Question: Write a caption explaining this figure to a reader.
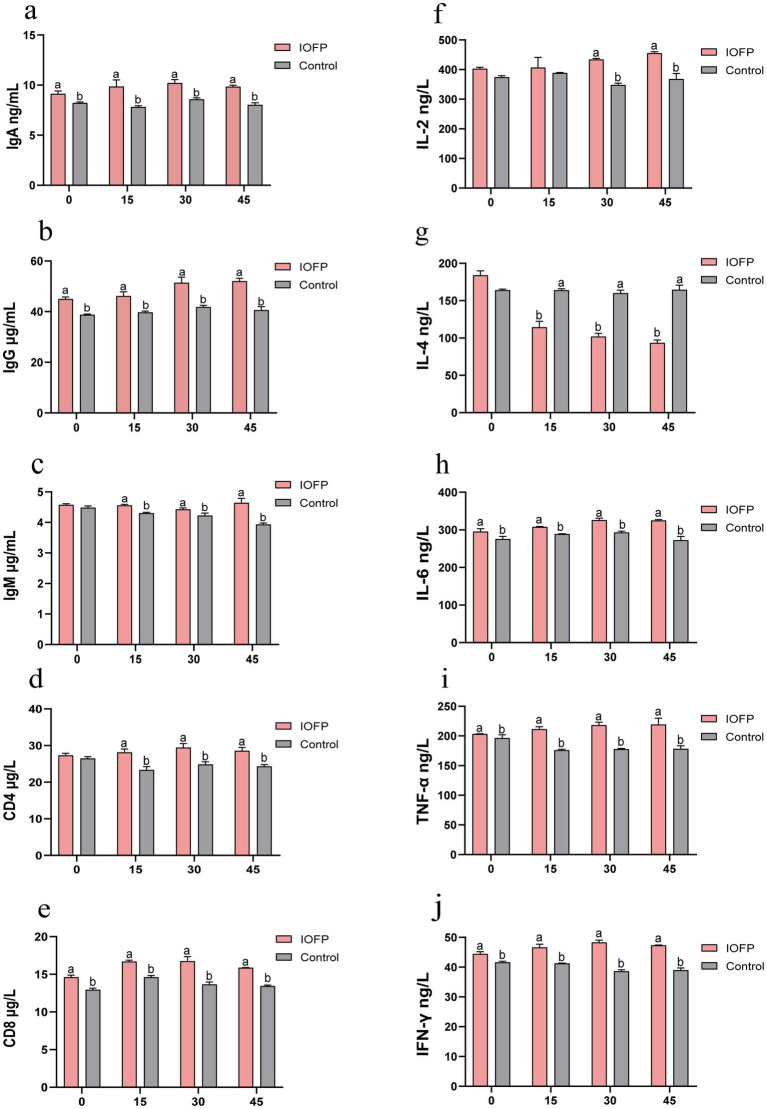
Answer: Effect of Inonotus obliquus fermentation product (IOFP) on serum biochemical indicators of cats. (a) Concentrations of IgA in the IOFP and control groups. (b) Concentrations of IgG in the IOFP and control groups. (c) Concentrations of IgM in the IOFP and control groups. (d) Concentrations of CD4 in the IOFP and control groups. (e) Concentrations of CD8 in the IOFP and control group. (f) Concentrations of IL-2 in the IOFP and control group. (g) Concentrations of IL-4 in the IOFP and control group. (h) Concentrations of IL-6 in the IOFP and control groups. (i) Concentrations of TNF- α in the IOFP and control groups. (j) Concentrations of IFN- γ in the IOFP and control groups. Different lowercase letters indicate a significant difference ( p < 0.05) between the IOFP and control groups. The error bars are based on the standard error of means.